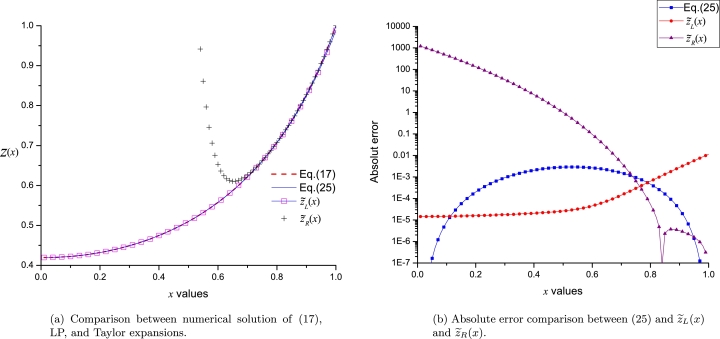
Comparing LP (25) and Taylor series expansions (26).